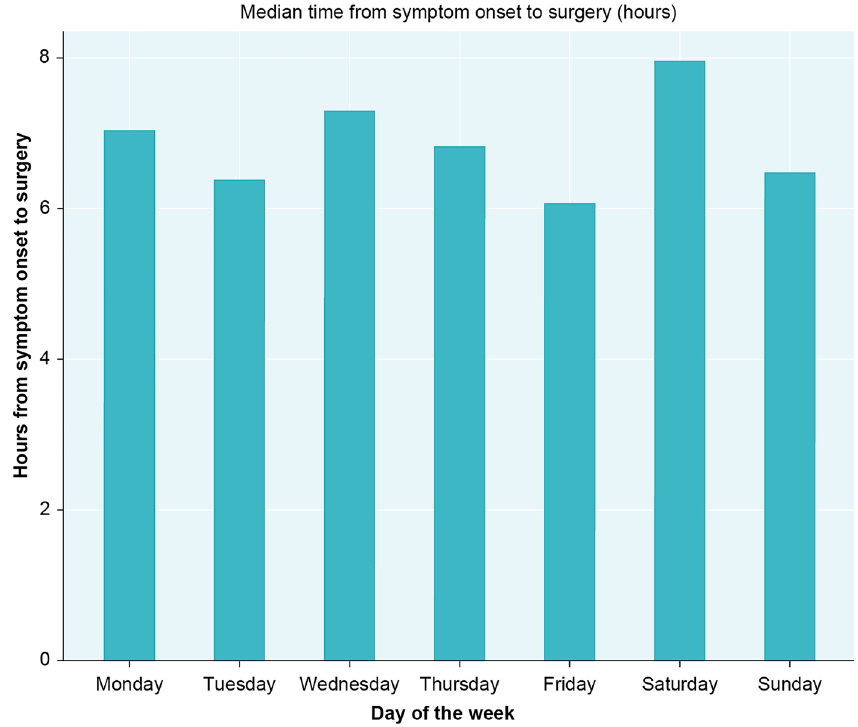
Figure 2. Median time between symptom onset and surgery on the different days of the